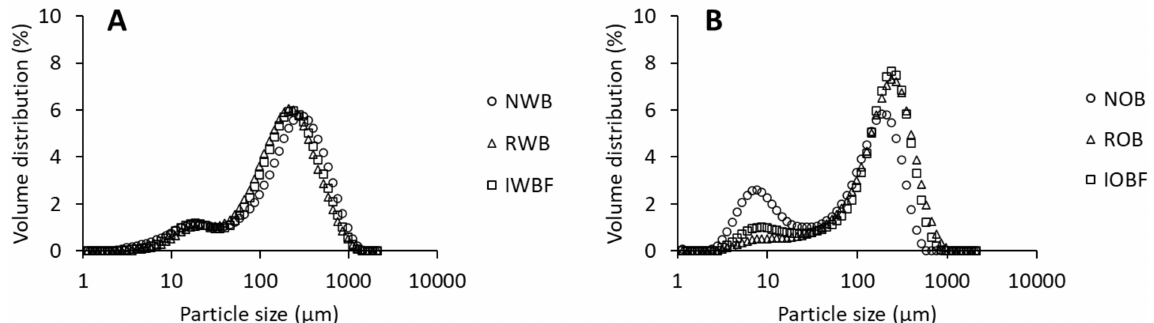
Figure 1. Particle size distribution of native brans, reconstituted brans, and insoluble fractions from wheat ( A ) and oat ( B ). Sample abbreviations are reported in Table